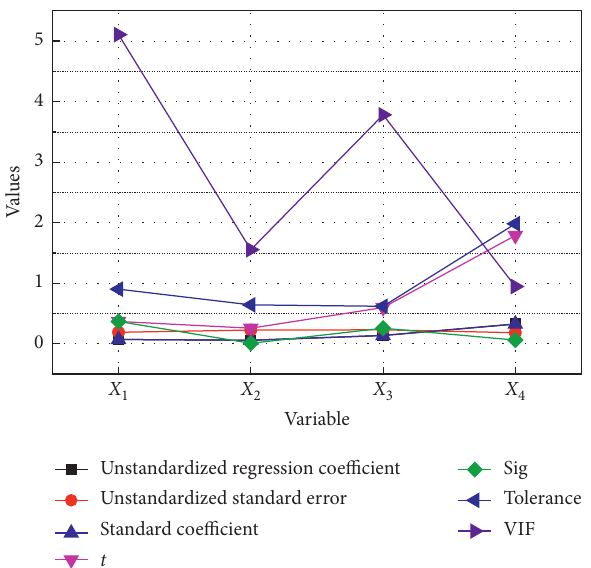
Figure 9: Regression coefficient test and significance